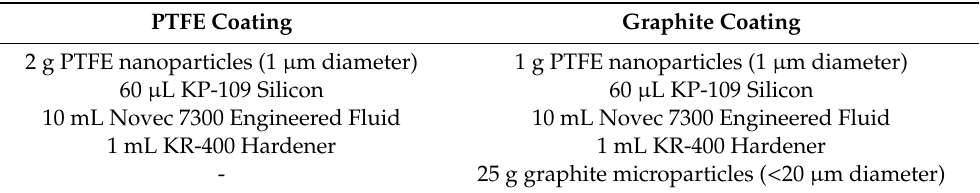
Table 1. Coating ingredients for 5 cm × 5 cm sample